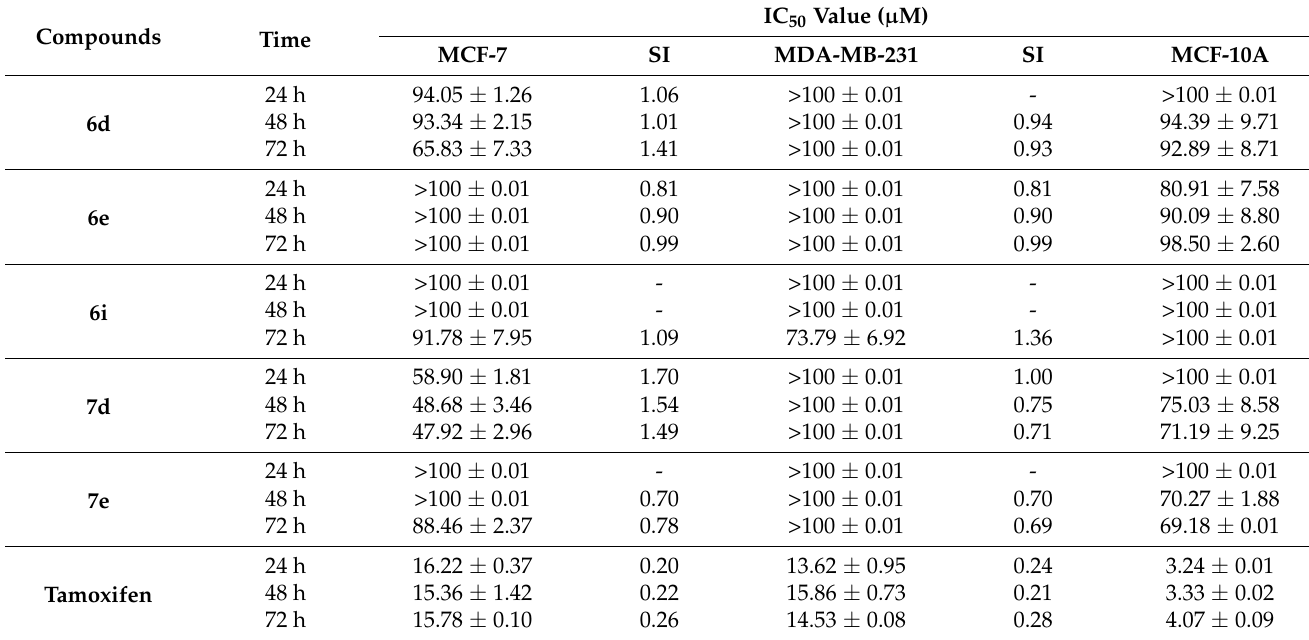
Table 2. Cytotoxicities (IC 50 values) and selectivity indexes (SI) of the most active bio-inspired 1,3-diarylpropene Heck reaction